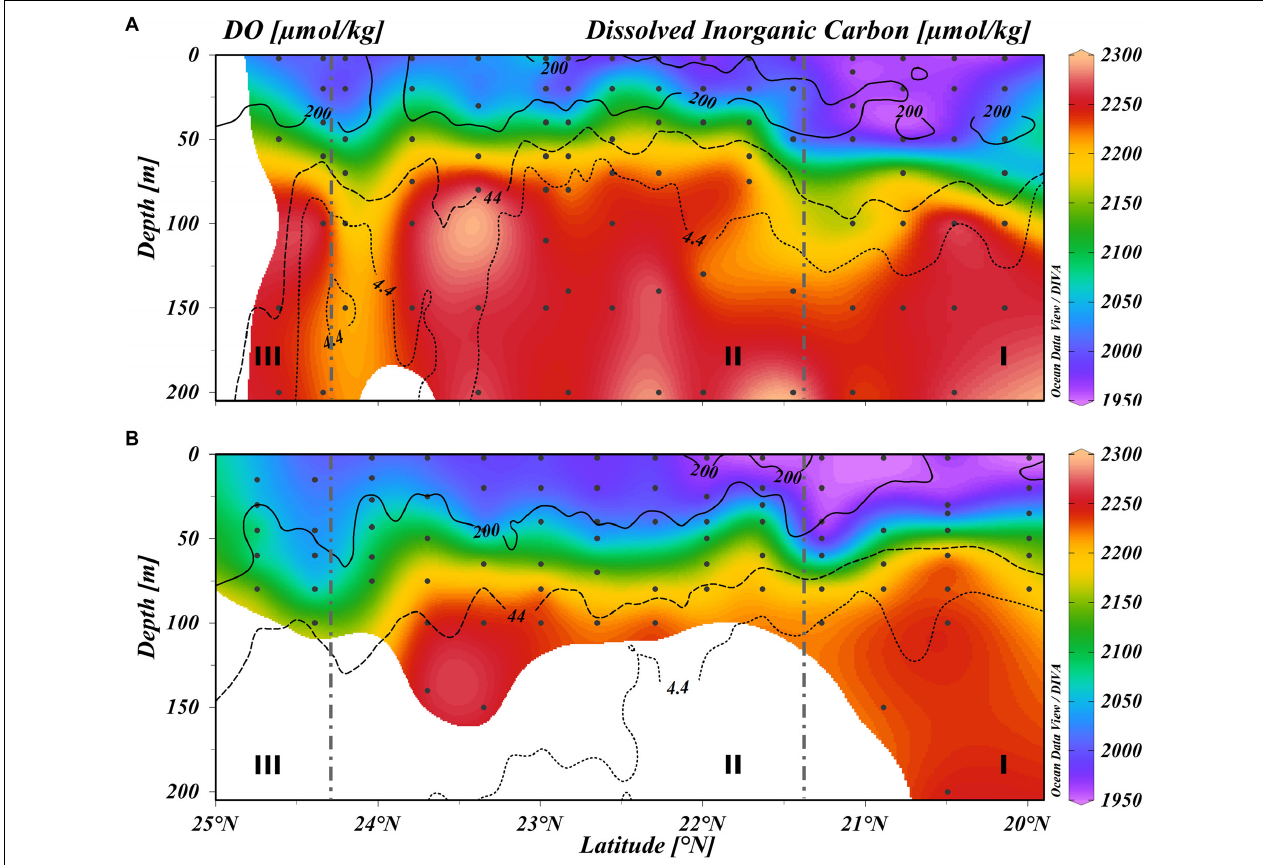
FIGURE 8 | Vertical distribution of dissolved inorganic carbon (DIC, µ mol/kg) and dissolved oxygen (DO, µ mol/kg) along transect 1 (see Figure 1 ). (A) June 2015, (B) March 2016. Refer to text for DO limits. Cabo Corrientes region (I) , Transitional region (II) , and entrance to the Gulf of California region (III)